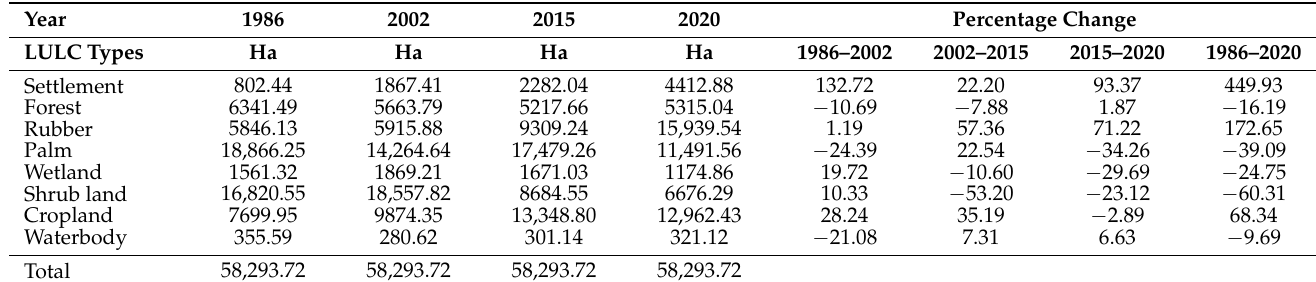
Table 4. Area of land cover category in ha and percentage of change from initial